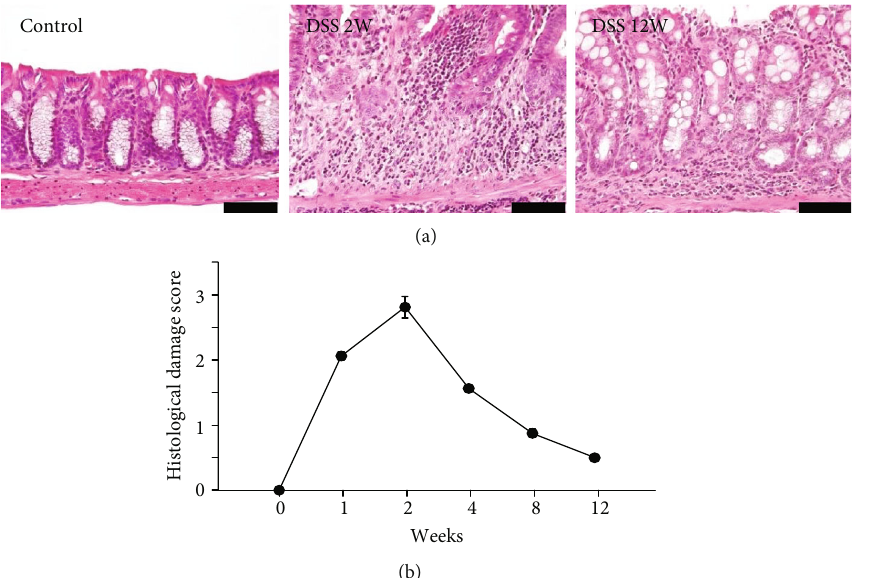
Figure 1: Histological evaluation of colonic tissue in mice with DSS-induced colitis. (a) Colonic tissues in the acute phase (2 weeks after DSS treatment) and healed phase (12 weeks after) and in controls. Bars indicating 50 μ m. (b) Histological damage score in colonic tissue of mice with DSS-induced